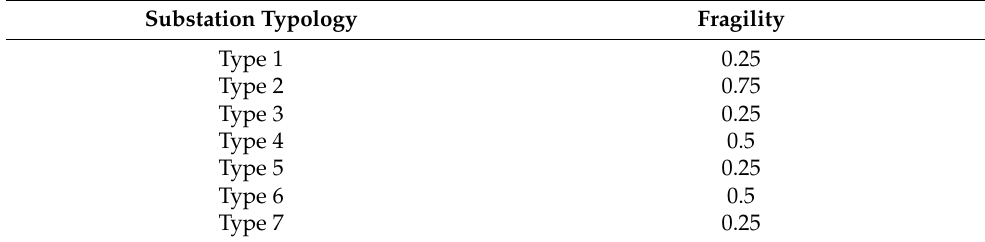
Table 1. K F,SS values for SS typology.